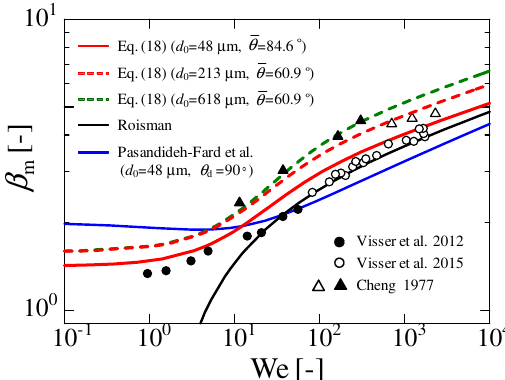
Figure 6. Comparison of our theory with existing experimental data for micro-sized water droplets at very high velocity. The black and white circles represent the existing experimental data for micro-sized water droplet impingement on a glass plate at very high velocity 8, 30 . The solid red line represents the theoretical results of Eq. (18) for d 0 = 48 μ m and θ = 84.6°. The dashed red and green lines represent the analytical results of Eq. (18) for d 0 = 213 μ m and θ = 60.9°, and for d 0 = 618 μ m and θ = 60.9°, respectively. The solid blue and black lines represent the analytical results given by Pasandideh-Fard et al . 10 and by Roisman 27 , respectively, for d 0 = 48 μ m and θ d = 90°. The white ( ▵ ) and black ( ▴ ) triangles represent the existing experimental data for water droplets, d 0 = 213 μ m and 618 μ m, respectively, on a coal surface. The reported static contact angle is 57° 31 . The white ( ⚬ ) and black ( ⦁ ) circles represent the existing experimental data for water droplets of d 0 = 48 μ m and 50 μ m, respectively, on a glass plate. The contact angle was not